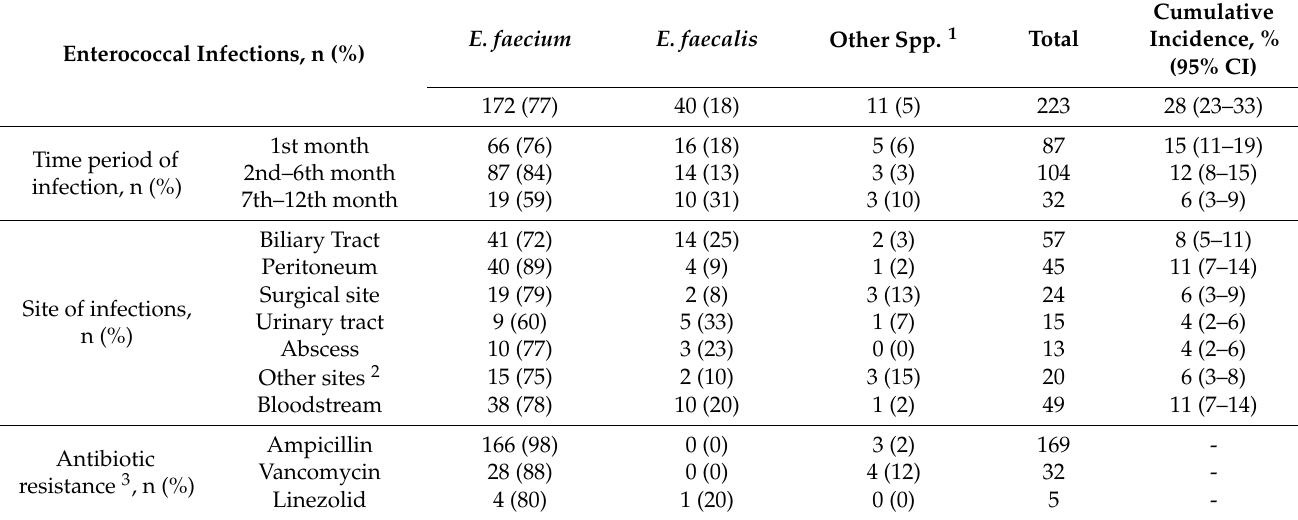
Figure 1. Cumulative incidence of first enterococcal infection and first bloodstream infections. ( a ) Cumulative incidence curve of first enterococcal infection post-LTx as a function of days post-LTx. ( b ) Cumulative incidence curve of first enterococcal bloodstream infections post-LTx as a function of days post-LTx. Vertical lines: At day 30 (brown), 180 (red), and 365 (yellow). Table 2. Characteristics of enterococcal